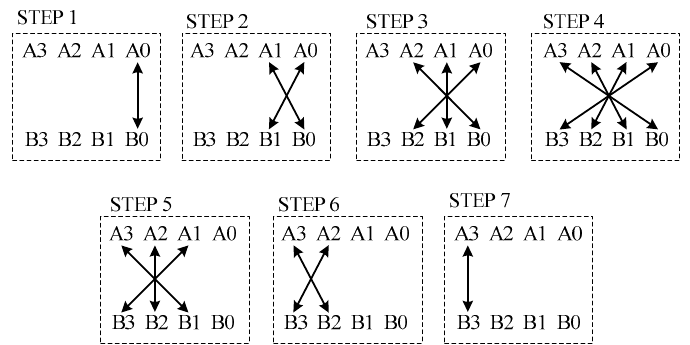
Figure 8. Multiplication steps of 4 × 4 Vedic multiplier.